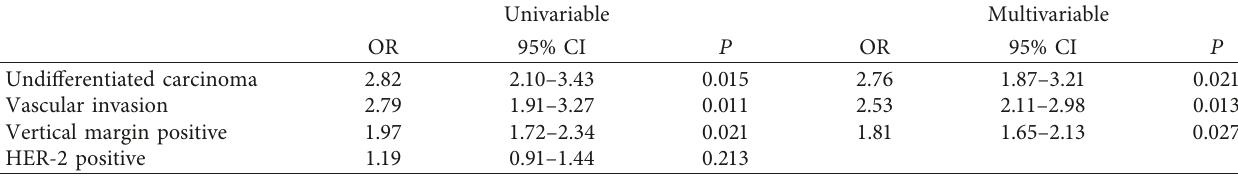
Table 3: Univariable analysis and multivariable logistic regression analysis for LN metastasis.